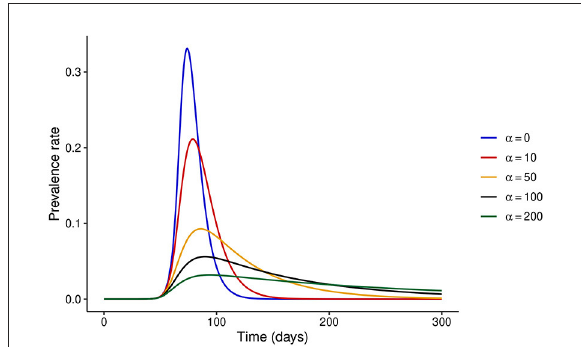
FIGURE1 Effect of increasing NPI stringency when the adherence level to NPIs is constant over time. It is clear that under this assumption, substantial increases in NPI stringency result in a considerable decrease in the prevalence at the peak of the epidemic.